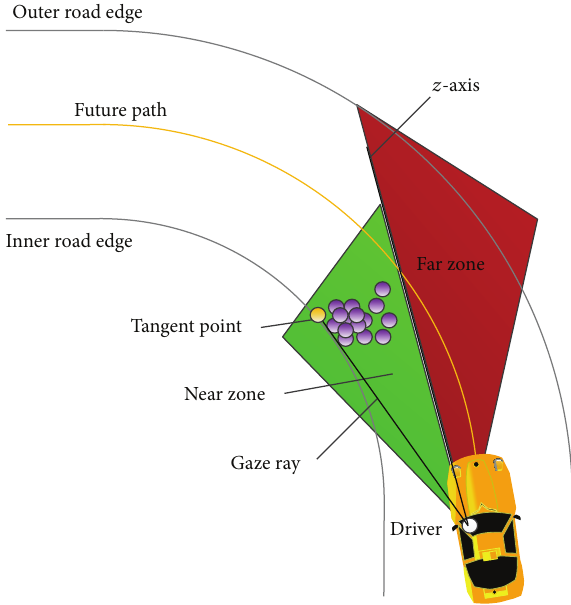
Figure 10: AOIs in left-turning